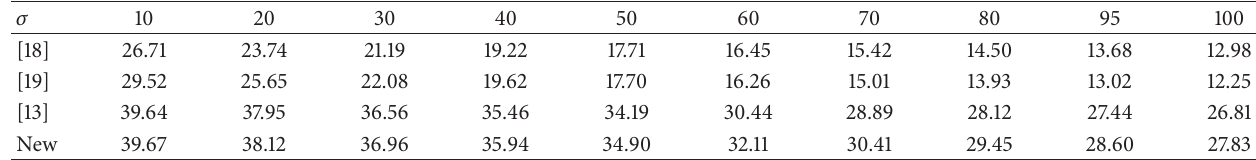
Table 2: PSNR of different algorithms with different Gaussian noise levels for Miss America video sequence.